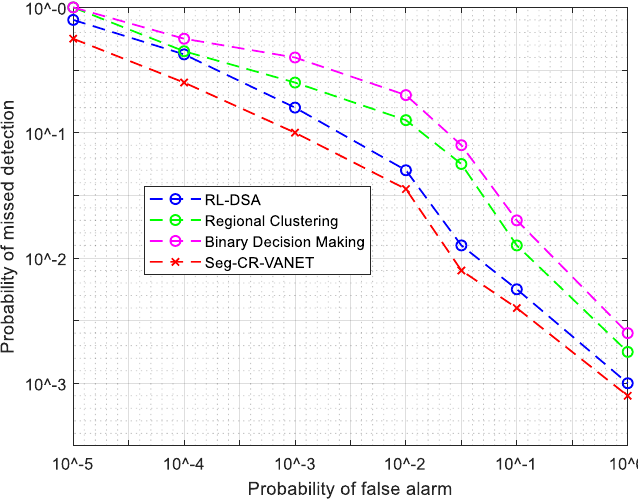
Figure 9. Probability of missed detection vs. probability of false alarm.